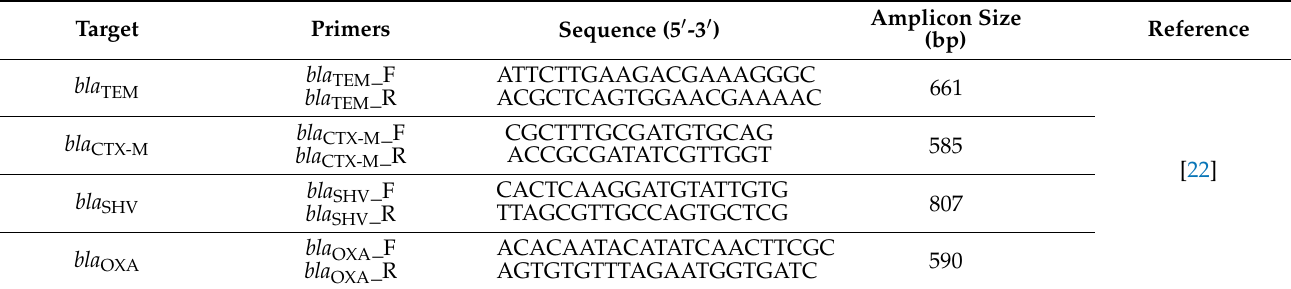
Table 1. Primers used in this study.